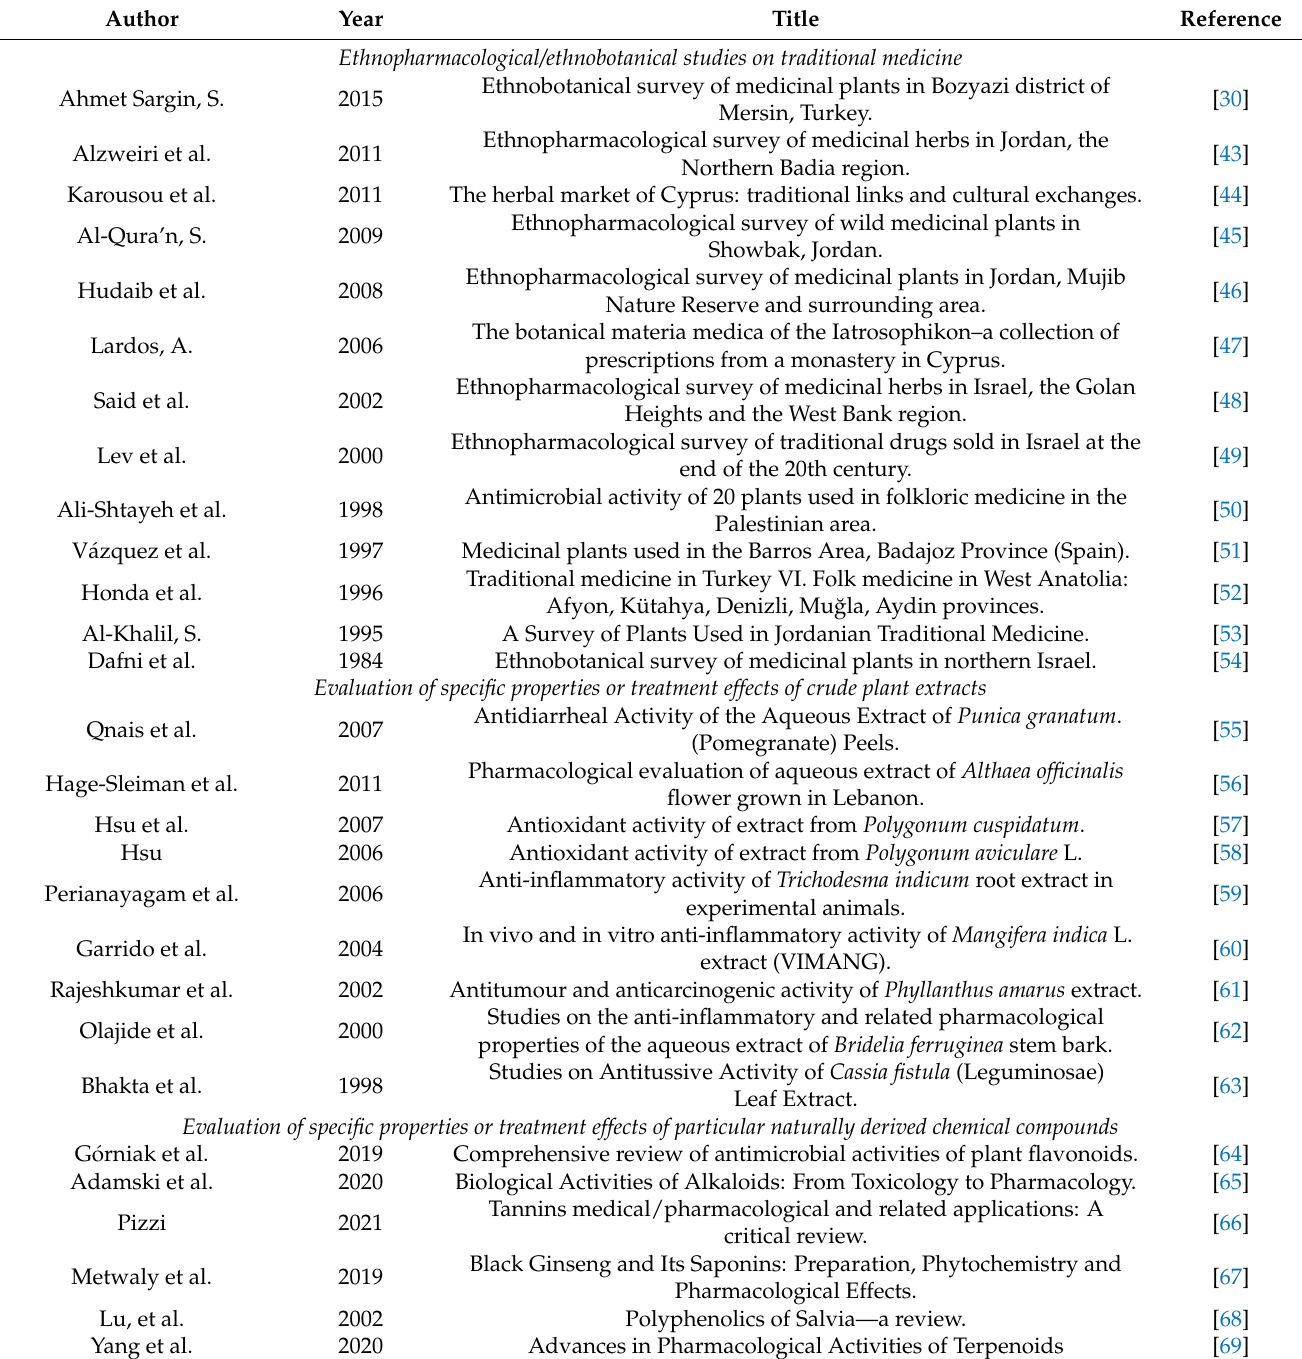
Table 1. Indicative studies of the research shift from identifying and recording the medicinal plant species used in traditional medicine to the evaluation of specific properties or treatment effects of crude plant extracts, or particular naturally derived chemical